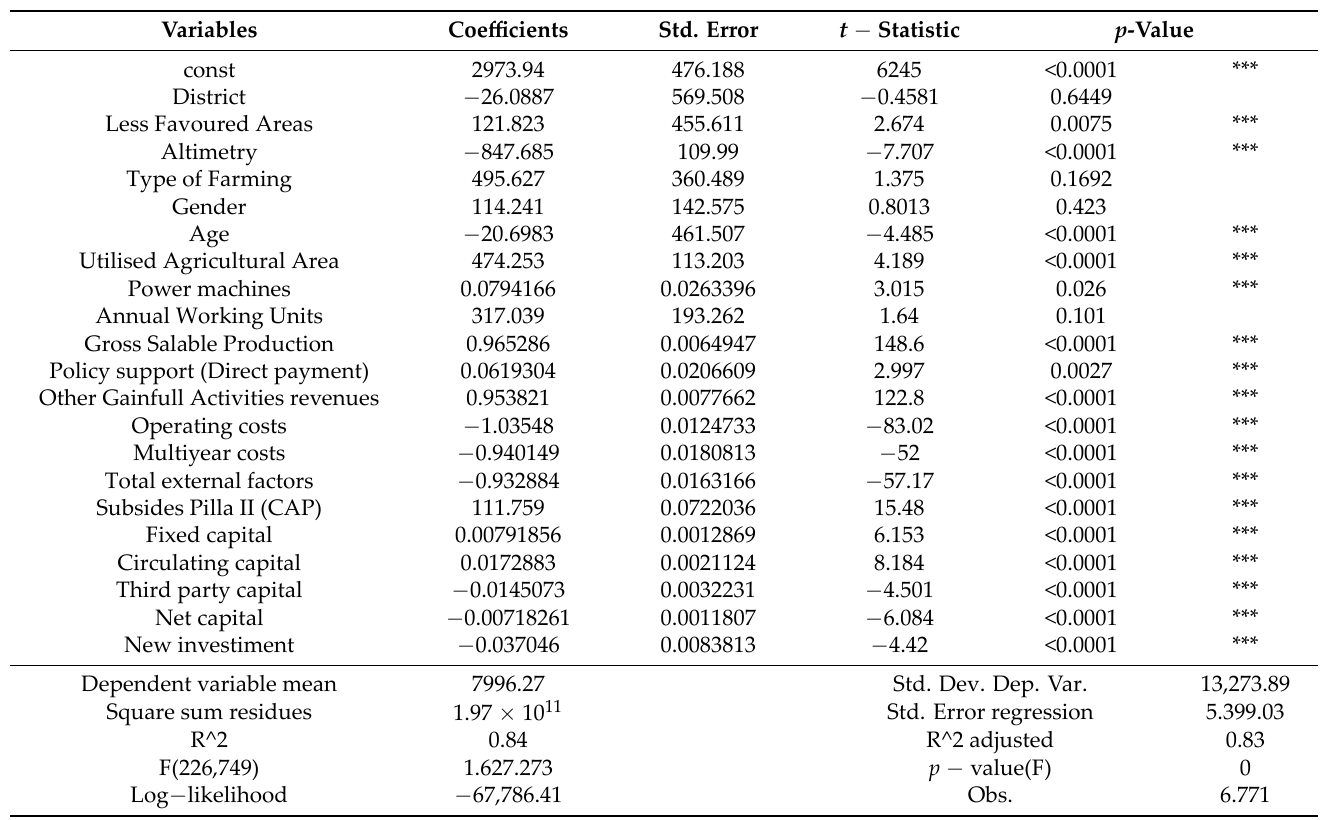
Table 6. The multiple regression model